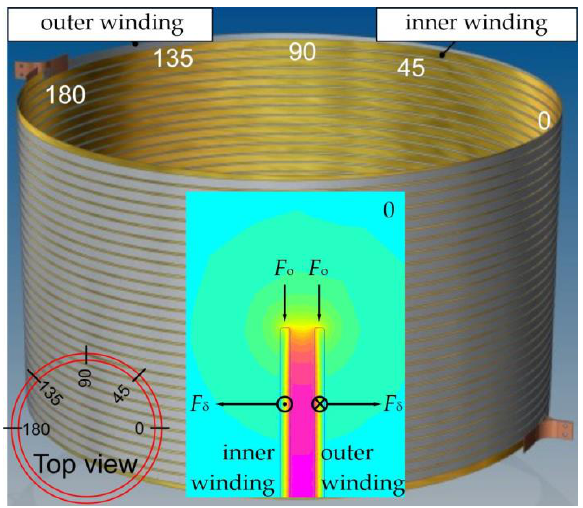
Figure 11. FEMM model of the SFCL windings, Red line 30 mm long between last turns is used to calculate axial and radial component of magnetic flux density.